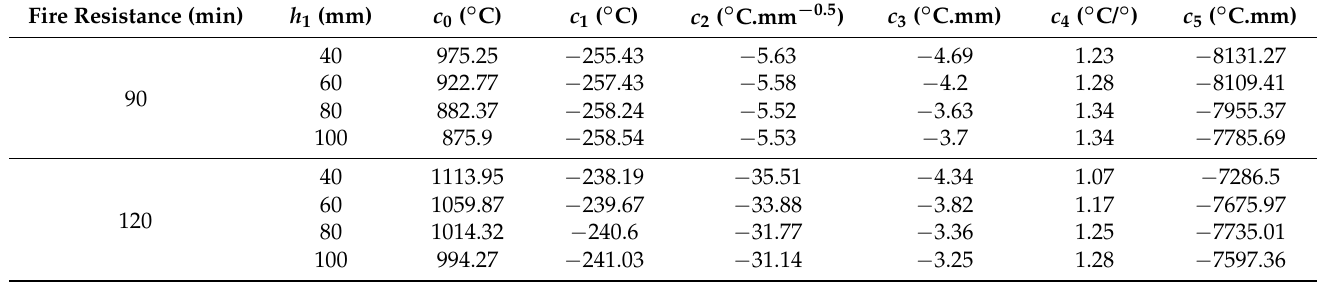
Table 8. New coefficients proposed to determine the temperature in the rebars under the fire curve Parametric 3.